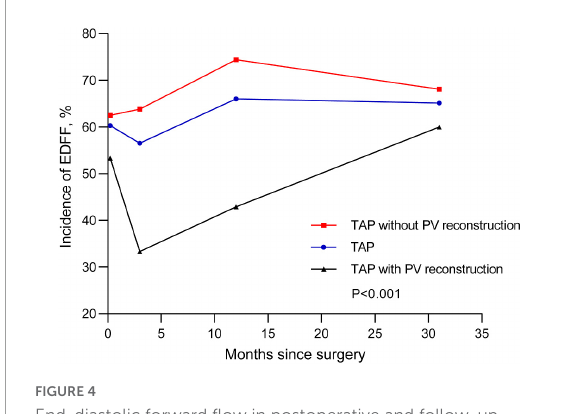
FIGURE4 End-diastolic forward flow in postoperative and follow-up echocardiography for patients with TAP. The lines are shown for temporal trend of EDFF in patients with TAP and two subsets, including TAP with and without PV reconstructions. EDFF, end-diastolic forward flow; PV, pulmonary valve; TAP, transannular